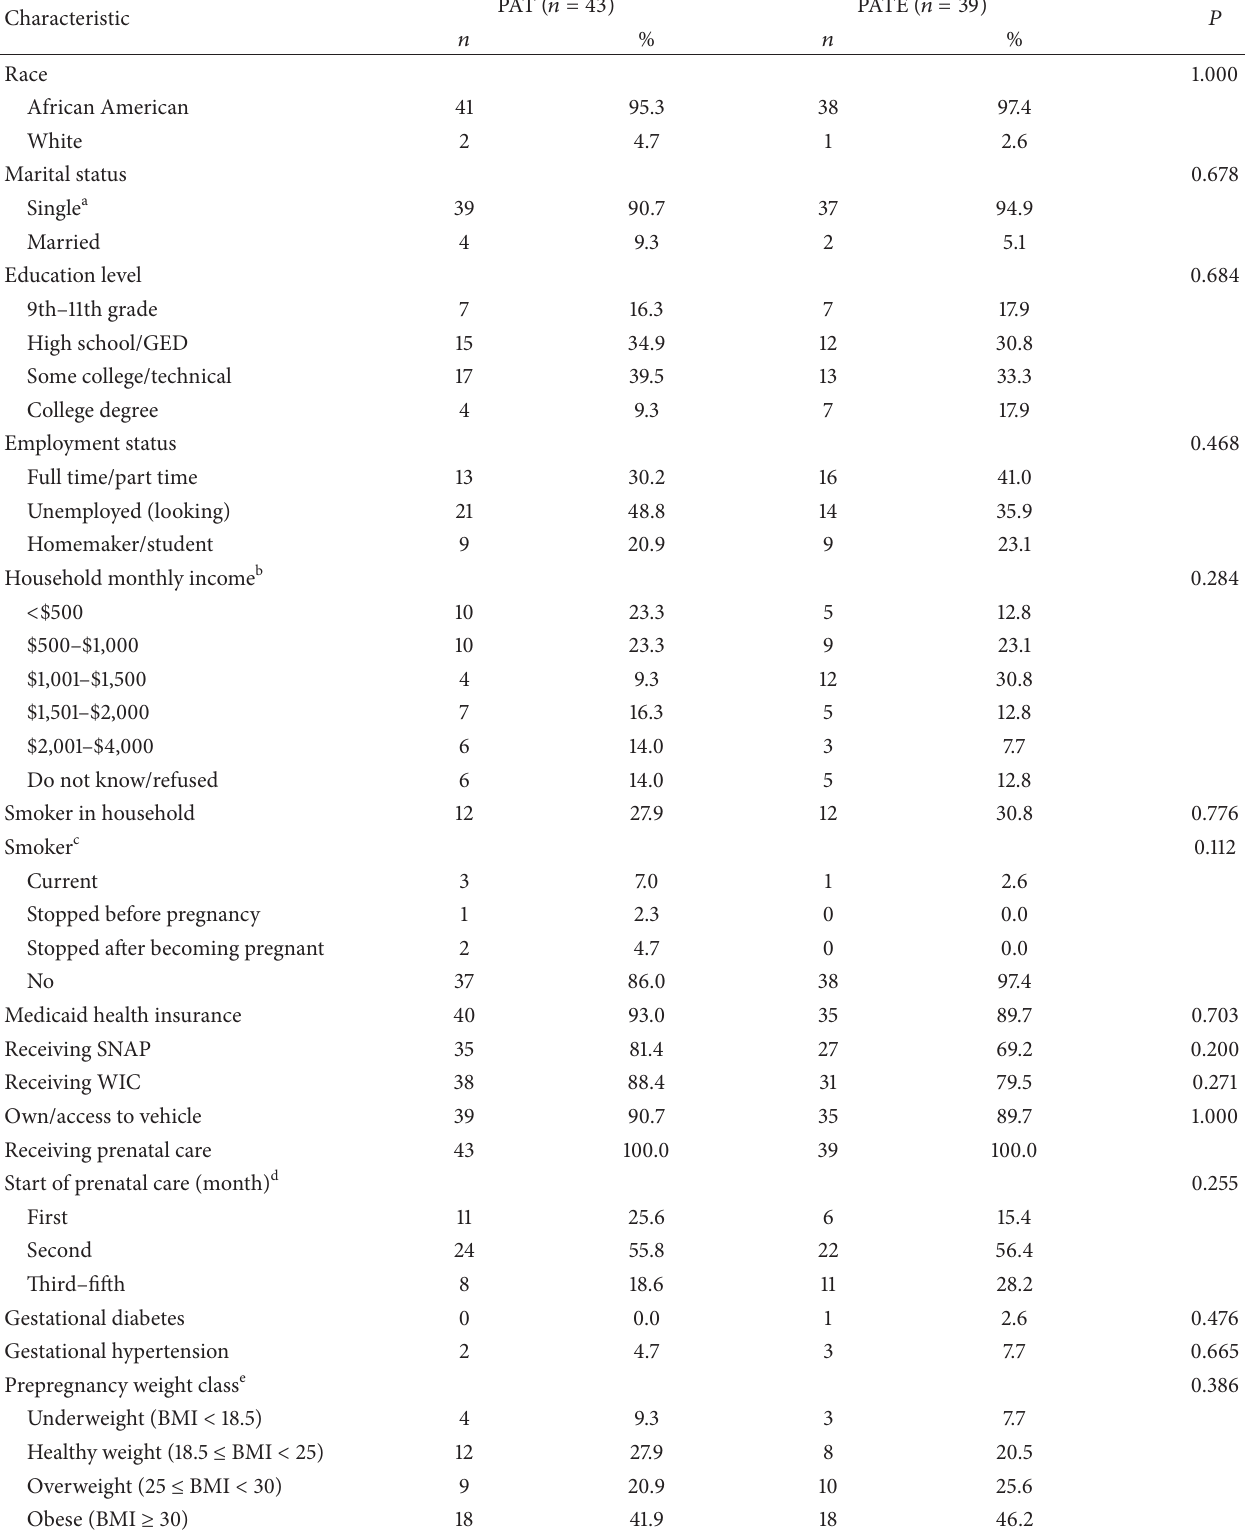
Table 1: Delta Healthy Sprouts participant baseline (early second trimester of pregnancy) demographic characteristics by treatment.